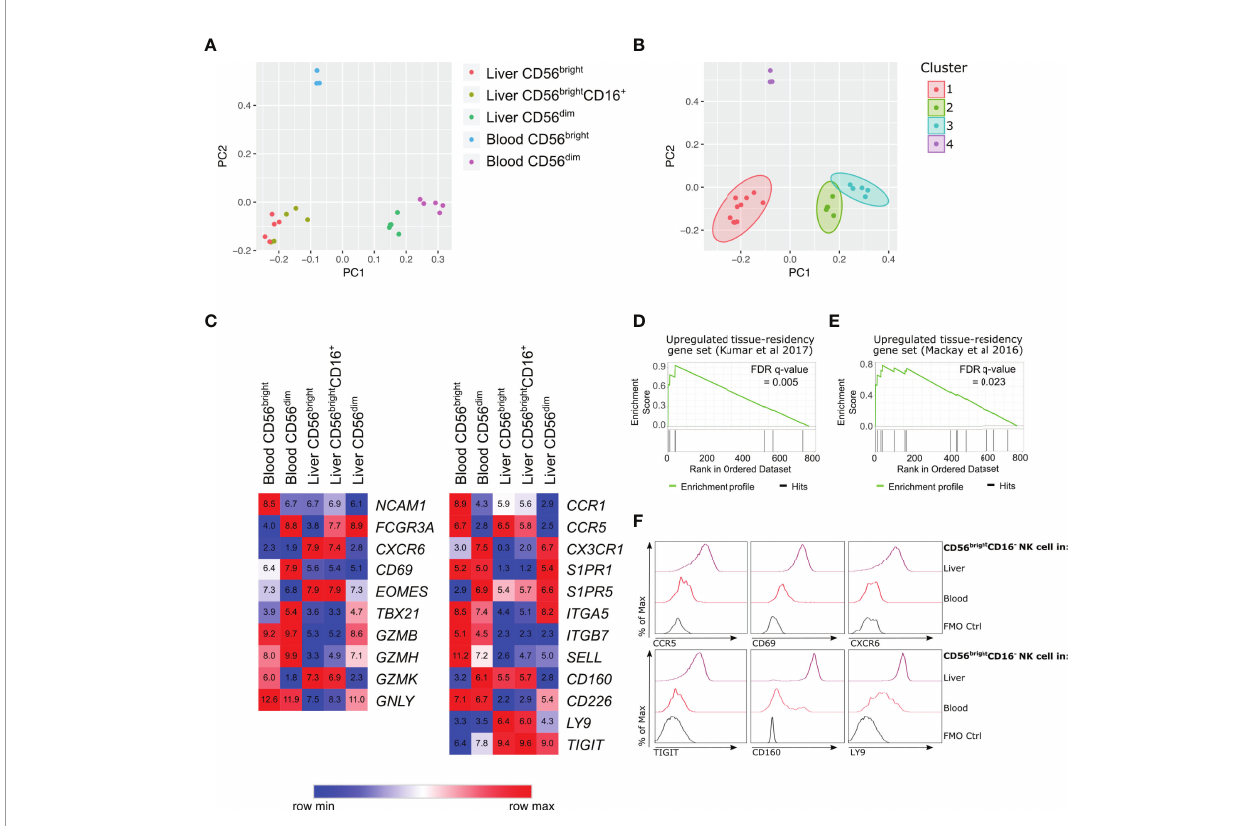
FIGURE 1 | Human hepatic CD56 bright NK cell populations express a distinct transcriptional pro fi le association with tissue residency. RNA-sequencing analysis of fl ow cytometry sorted NK cell subpopulations from healthy human liver perfusate (n = 5) and healthy human peripheral blood (n = 5). (A) , PCA analysis of 405 differentially expressed genes (ANOVA q-value < 0.05) and (B) , K-means clustering of PCA. (C) , Heatmap of average gene expression of selected NK cell-related genes. (D) , Gene-set enrichment analysis comparing 769 genes with >2 fold change between liver and blood CD56 bright CD16 - NK cells, against up-regulated genes in tissue-resident lymphocytes from Kumar et al., 2017 (40). (E) , Gene-set enrichment analysis comparing 769 genes with >2 fold change between liver and blood CD56 bright CD16 - NK cells, against up-regulated genes in tissue-resident lymphocytes from Mackay et al., 2016 (41). (F) , Representative histograms of protein validation of differentially regulated genes via fl ow cytometry on CD56 bright CD16 - NK cells (n =